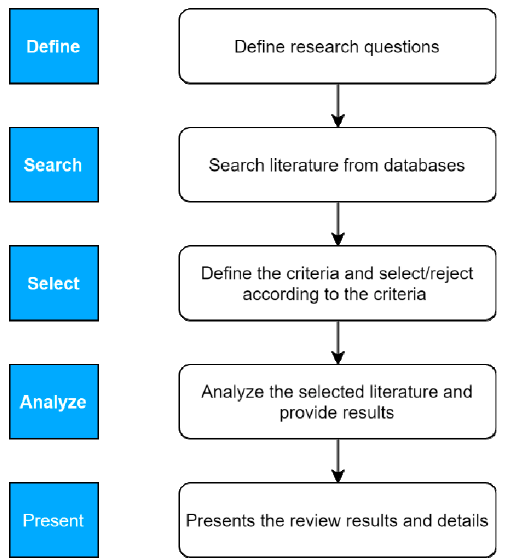
Figure 1. Literature review methodology.